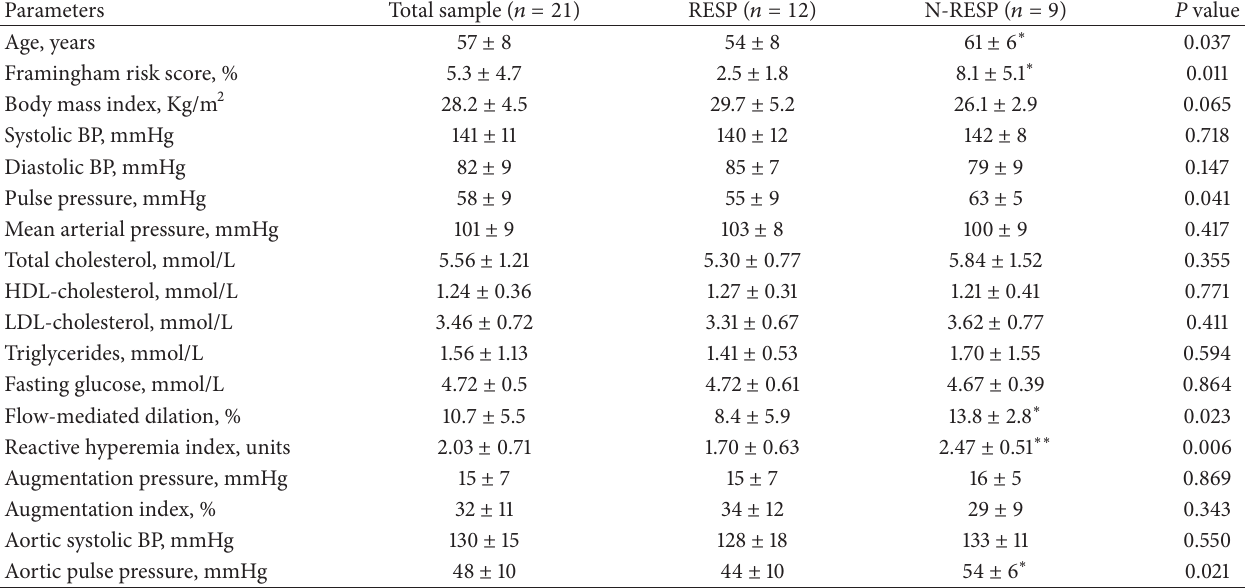
Table 1: Baseline characteristics of study population and responder (RESP) and nonresponder (N-RESP) groups.